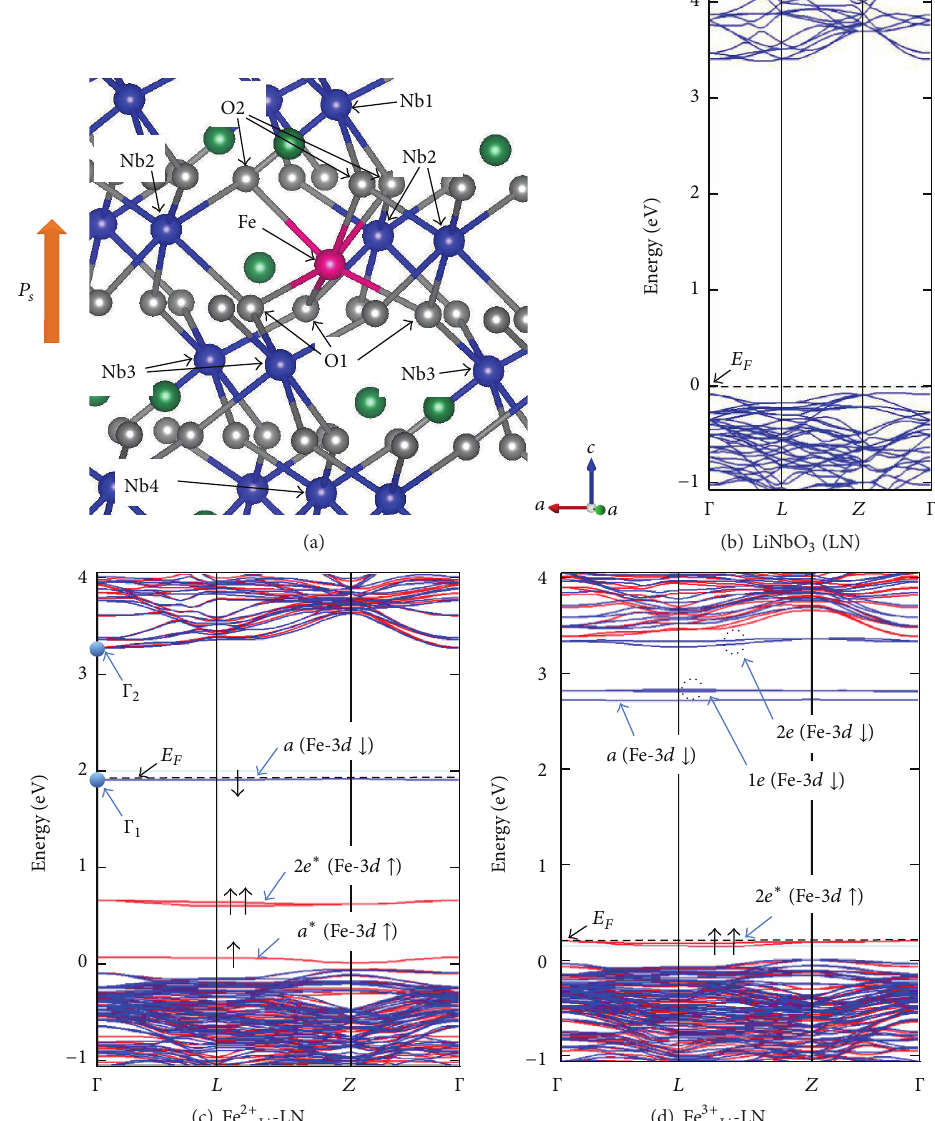
Figure 1: (a) Crystal structure around Fe 2+ in the Fe 2+ Li -LN cell after the geometrical optimization obtained by the DFT calculations and the electronic band structures of the (b) LN, (c) Fe 2+ Li -LN, and (d) Fe 3+ Li -LN